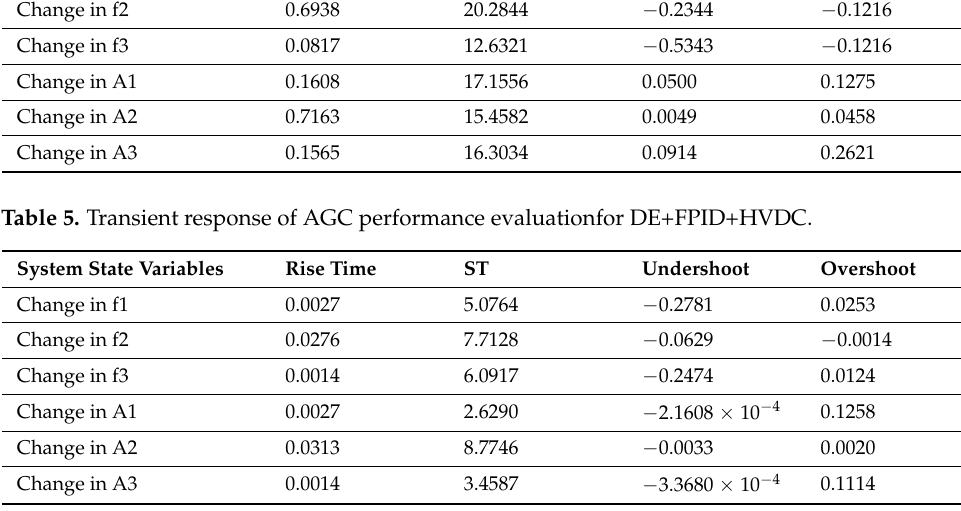
Figure 29. Change in ACE responses of area 1, area 2, and area 3 for random load change in area 3 only.